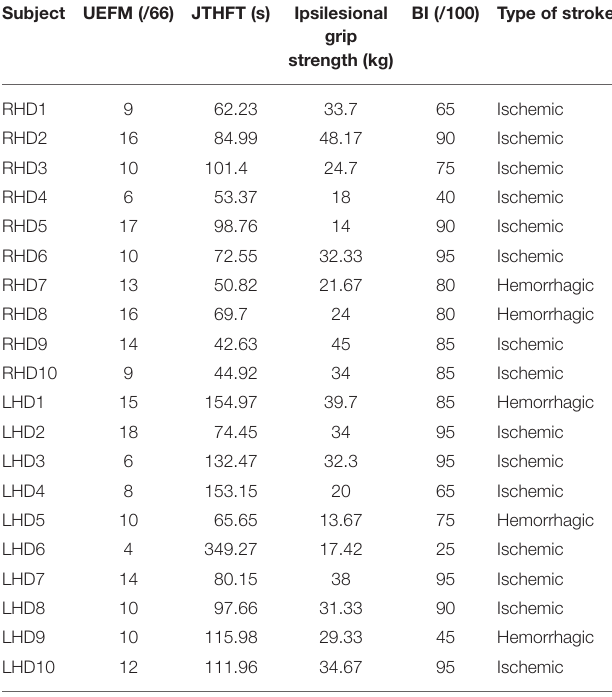
TABLE 1 | Summary of participant information. panel of Figure 2 . The LHD group exhibited a